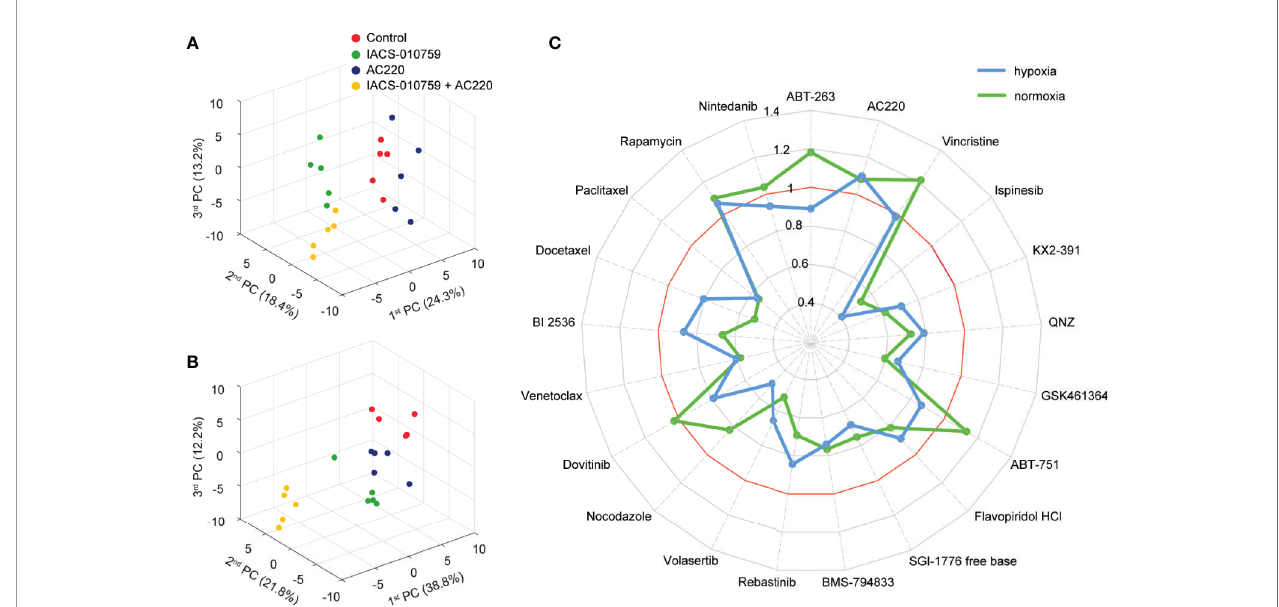
FIGURE 2 | Untargeted metabolomics-based phenotypic screening by DIMS displays distinct metabolic modulations upon drug treatments and prioritizes synergistic drug combinations at the multivariate level. (A, B) 3D scores plots obtained from the PCA of metabolomic pro fi les for OCI-AML3 treated for 24 h with control, 30 nM IACS-010759 and/or 100 nM AC220 (selected from the secondary screening data as an example) in hypoxia (A) and normoxia (B) . (C) Radar plot of PEDS values of the 21 combinations evaluated in the DIMS secondary screening to quantify drug synergism under both hypoxia (blue) and normoxia (green) conditions after 24 h